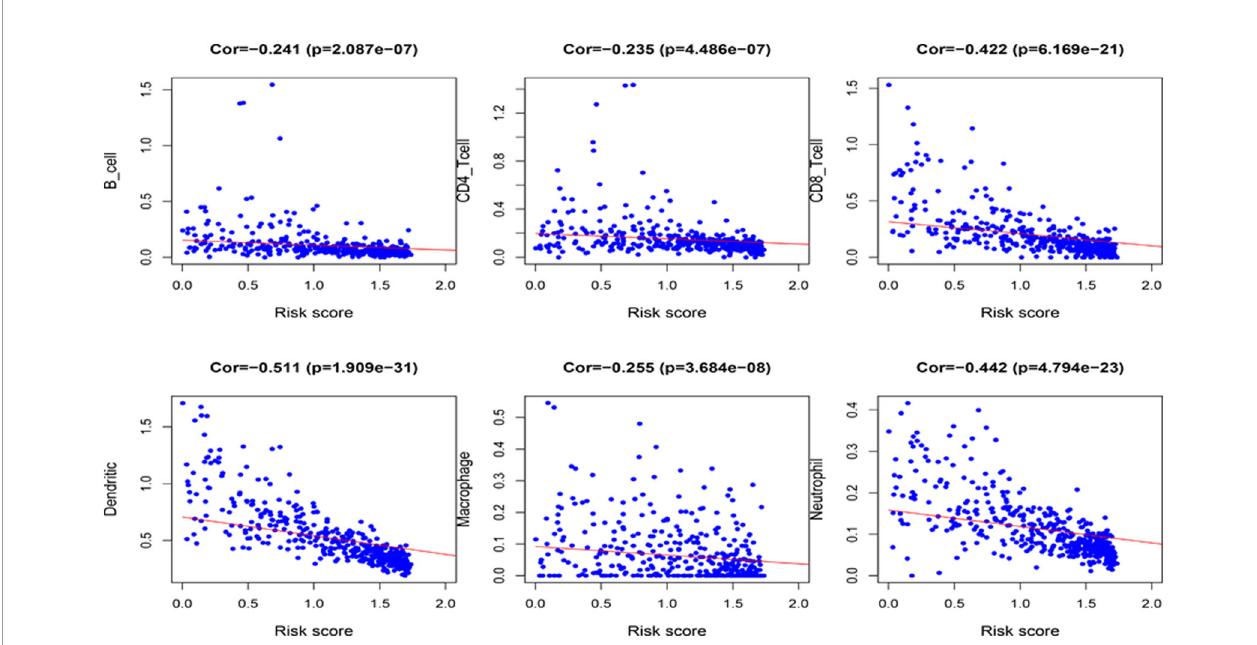
FIGURE 10 | Correlation between the 4 immune-related genes prognostic signature for melanoma and the in fi ltration of immune cell subtypes. The six most relevant in fi ltration of immune cell subtypes are shown in the fi